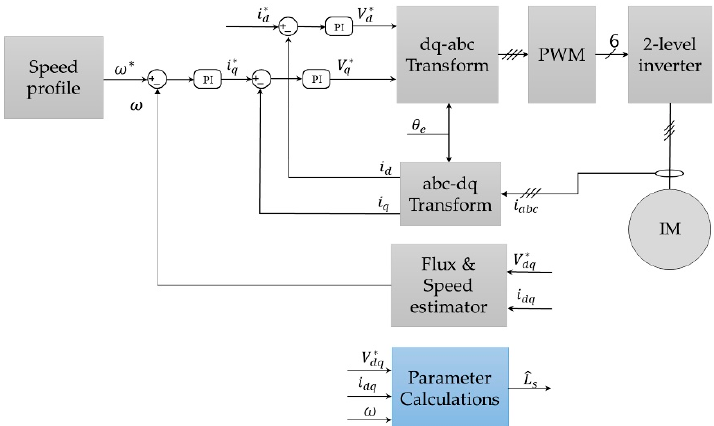
Figure 2. Block diagram of conventional stator inductance identification method based on rotational tests.